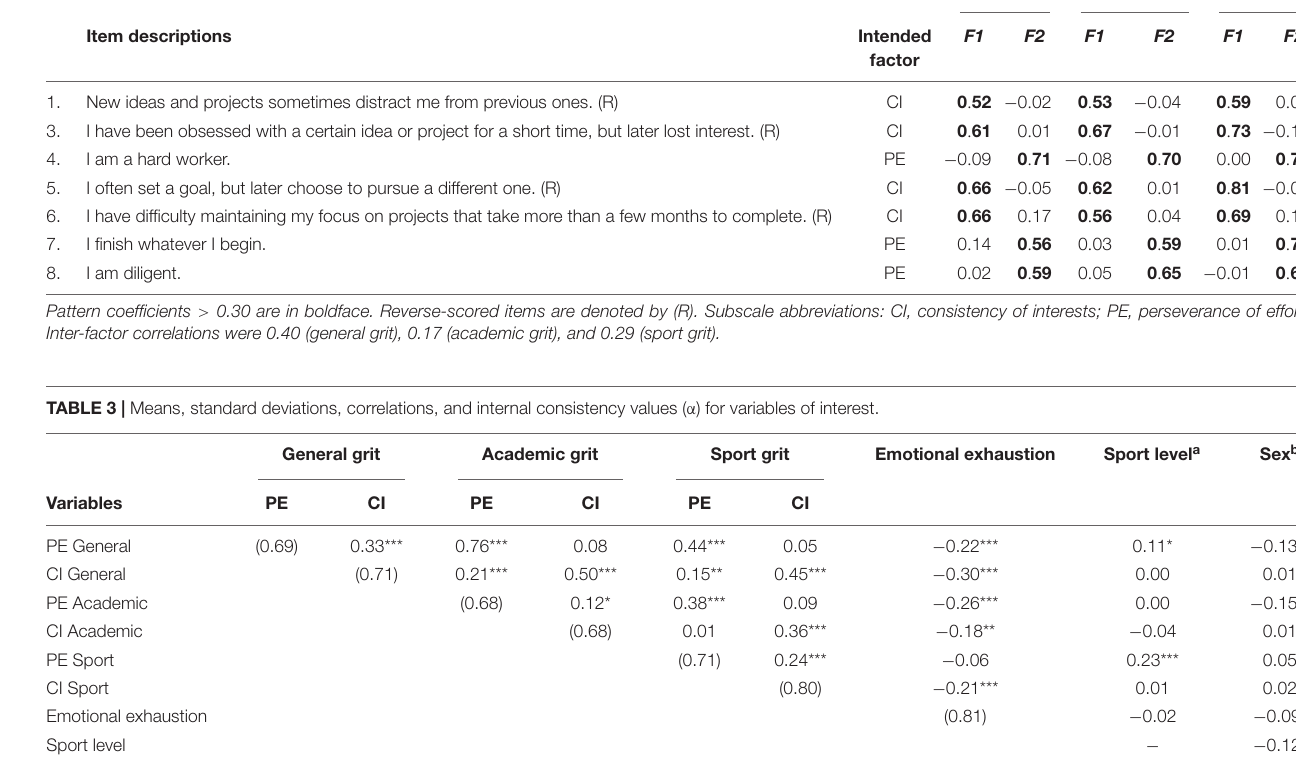
General Academic